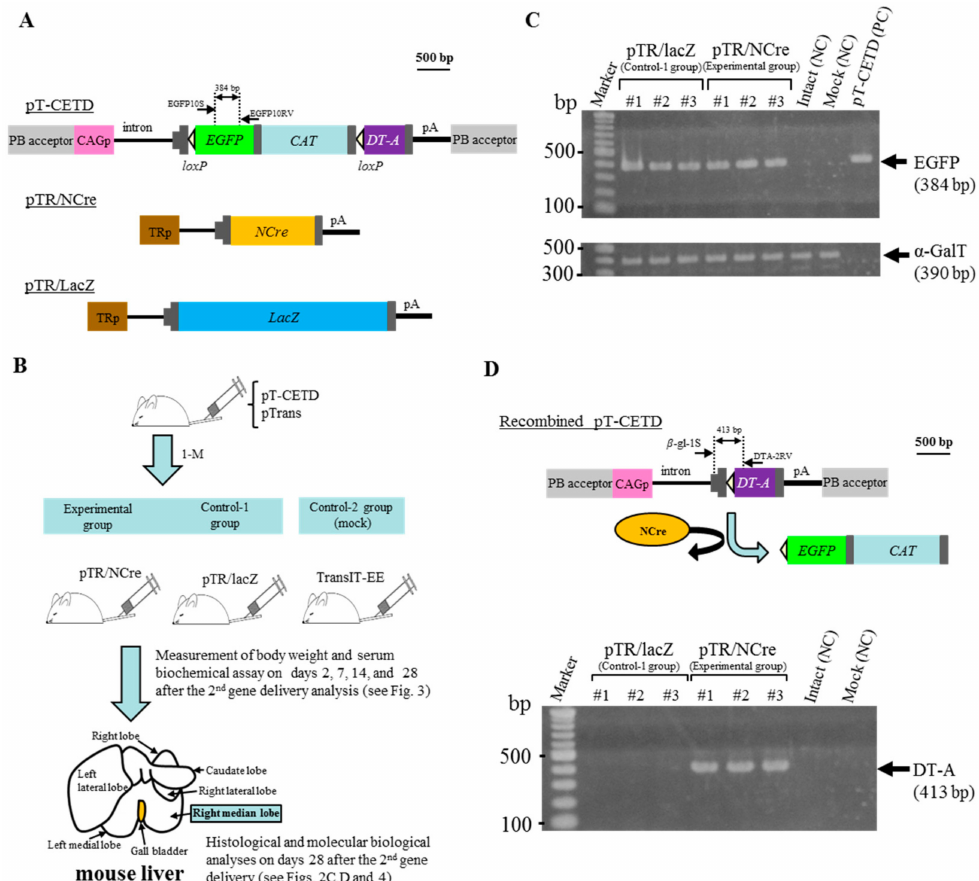
Figure 2. Hydrodynamics-based gene delivery and PB transposon system enable the creation of disease models for liver dysfunction. ( A ) Structure of plasmid vectors used for the creation of liver disease model mice. The position of primers is shown above each plasmid; ( B ) Schematic representation of experimental outline for the creation of mice with liver dysfunction. Adult ICR males are first subjected to HGD with a solution containing pT-CETD and pTrans. One month later, they are then subjected to the second HGD with a solution containing pTR/NCre (experimental group) or pTR/lacZ (control-1 group). Males are also mock-injected as control-2 group. After the second gene delivery and mock injection, blood is collected from these mice on the indicated days. Twenty-eight days after the second gene delivery and mock injection, mice are subjected to blood collection and then sacrificed to dissect their liver (right median lobe) for pathological and molecular biological analyses; ( C ) PCR analysis of genomic DNA isolated from the HGD-treated males in the experimental and control-1 groups. For each group, three females (#1 to #3) were analyzed. Genomic DNA (approximately 5 ng) was PCR-amplified using primers recognizing EGFP cDNA in pT-EGFP. Simultaneously, the same amounts of DNA were PCR-amplified using primers for detection of the endogenous α -GalT gene and used as internal controls. Intact (NC), genomic DNA from intact mouse liver used as a negative control; Mock (NC), genomic DNA isolated from mice in the control-2 group; PC, plasmid pT-CETD (5 ng) used as positive controls for EGFP cDNA sequence. Marker, 100-bp ladder markers; ( D ) Structure of pT-CETD after Cre-mediated recombination (upper panel) and PCR analysis of genomic DNA isolated from the females in the experimental and control-1 groups 28 days after the second gene delivery (lower panel). As shown in the upper panel, Cre protein provided from pTR/NCre acts to remove the loxP -flanked sequences in pT-CETD and finally allows the DT-A gene to be expressed by the upstream CAG. The DT-A gene after recombination can be detected by PCR using β -gl-1S and DTA-2RV primer set, as shown in the upper panel. Intact (NC), genomic DNA from intact mouse liver used as a negative control; Mock (NC), genomic DNA isolated from mice in the control-2 group. Marker, 100-bp ladder